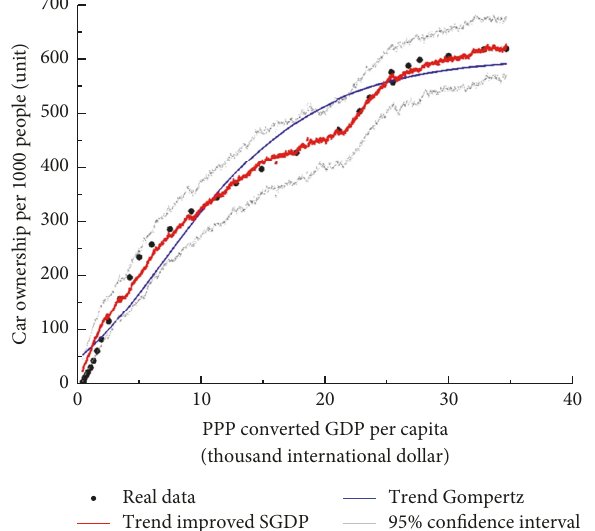
Figure 5: Real data versus Improved SDE Gompertz versus Trend Gompertz in Japan.